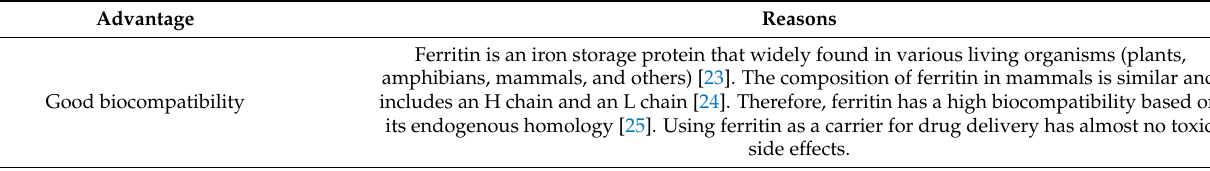
Table 1. The key advantages of ferritin-based clinical